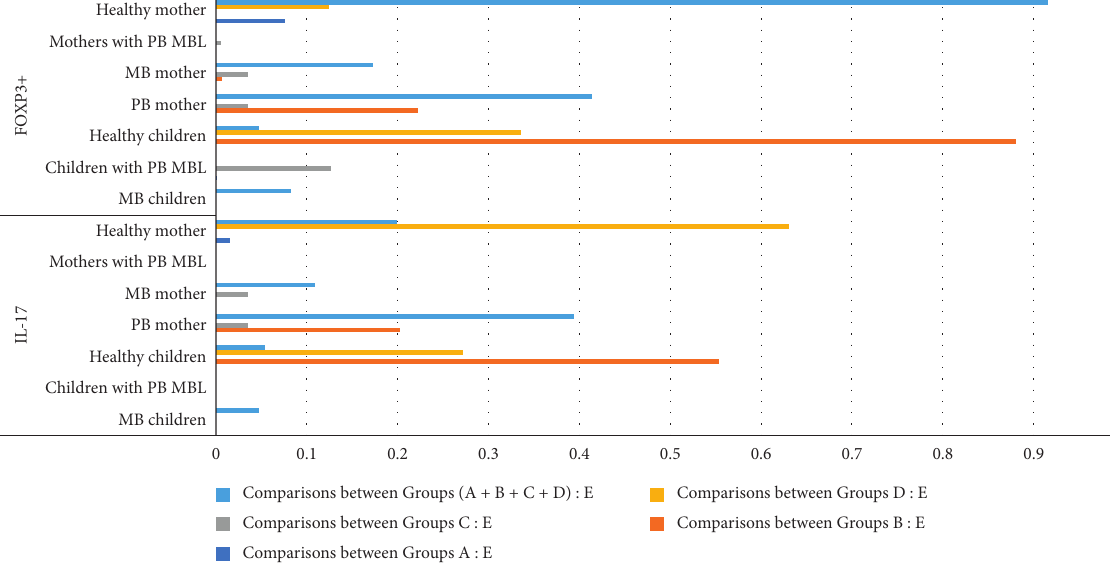
Figure 3: The comparisons of p values between groups